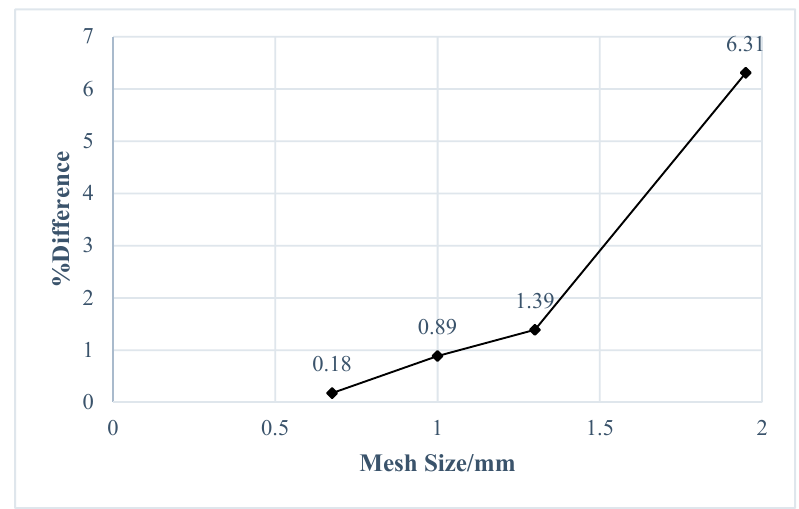
Figure 9. Mesh refinement study results.